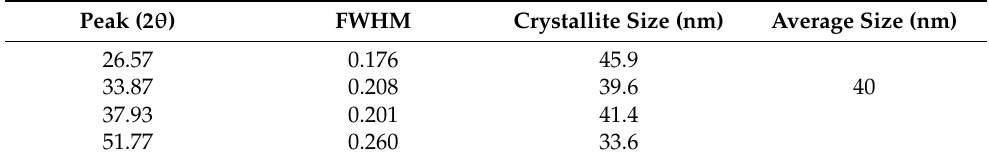
Table 2. Grain size estimation of SnO 2